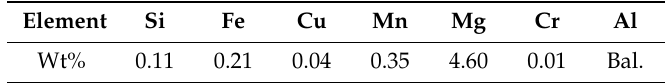
Table 2. Chemical composition of direct casted (DC) Al 5182 aluminum